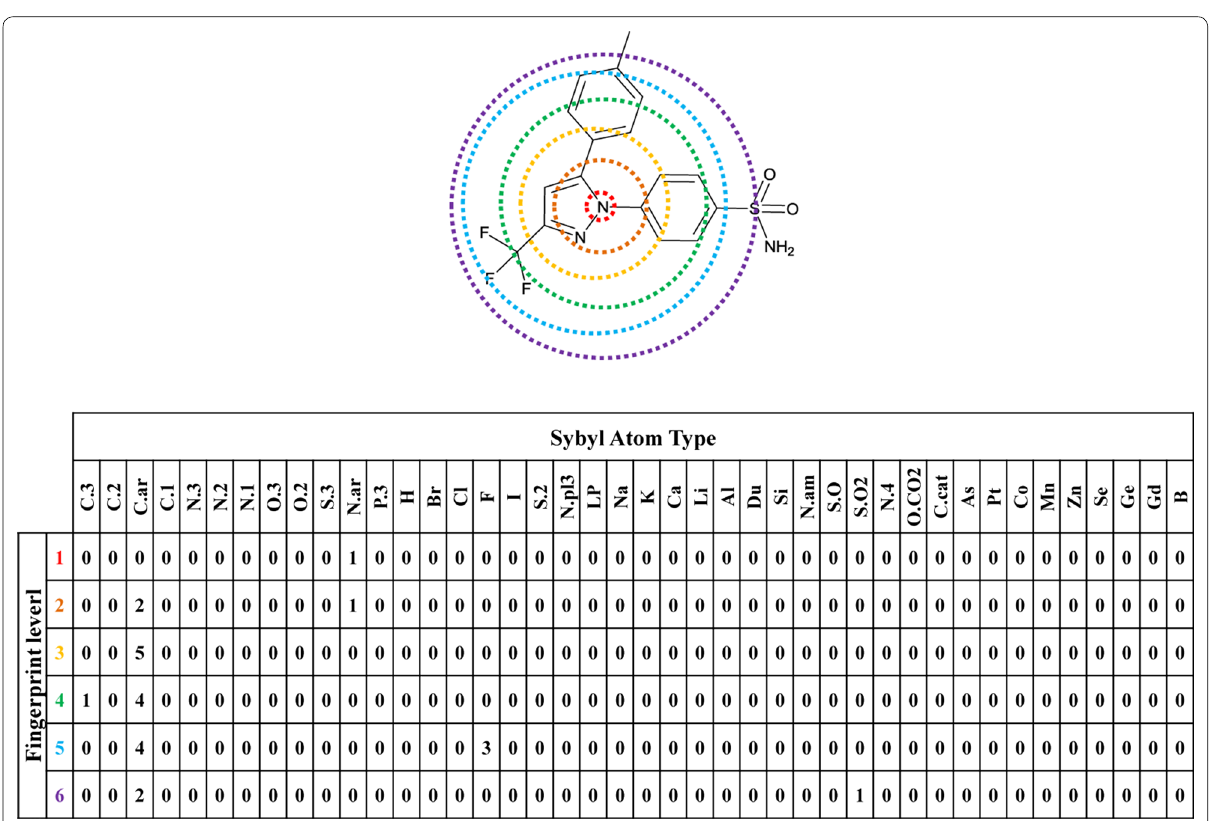
Fig. 2 Construction of six layers topological atom fingerprint. The starting layer is an N atom (sybyl atom type: N.ar) in the red circle . The successive layers range from orange to yellow , green , blue , and violet . Atoms lying far away from the six-layer are not considered. Below the fingerprint matrix represents the counts of SYBYL atoms types and another 9 atoms that involved in metabolic reactions at each layer. The rows are colored according to the same color scheme of the figure